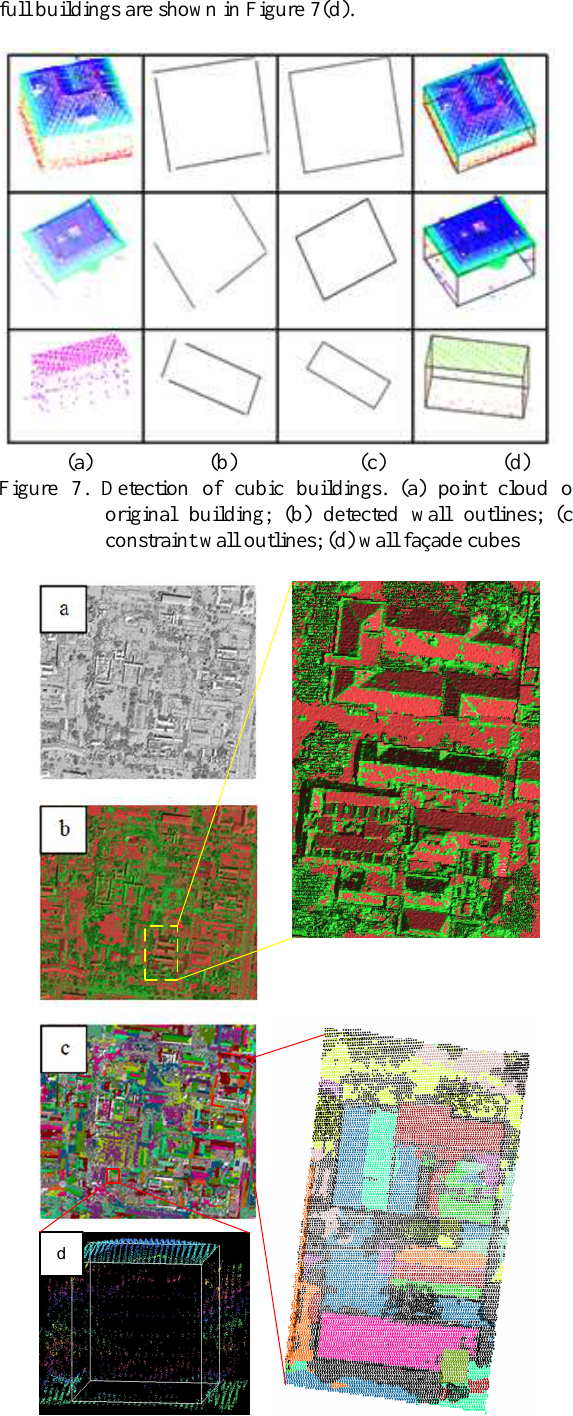
Figure 8. Result of Melbourne campus site. (a) raw data, (b) detected planar points (red) and non-planar points (green), (c) generated segments, (d) reconstructed